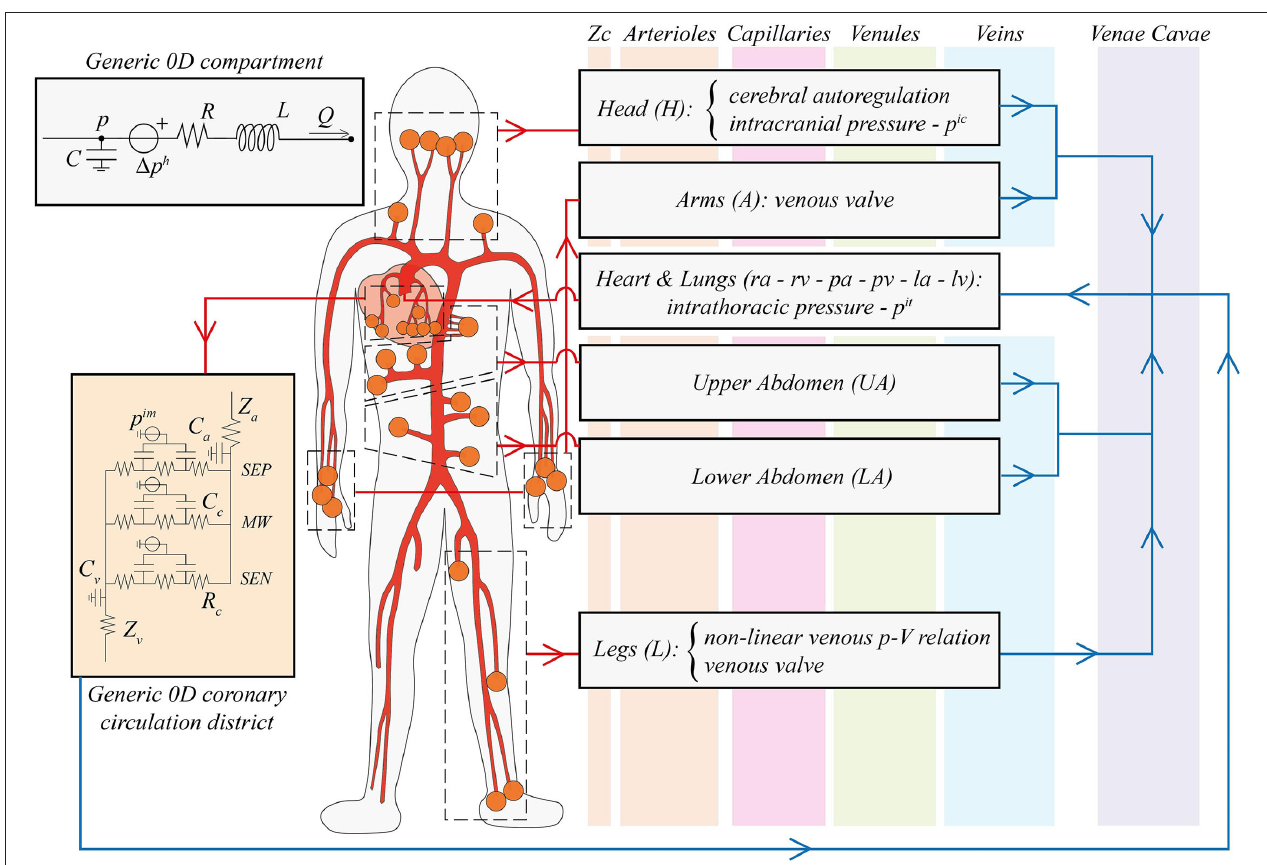
FIGURE 1 | Schematic illustration of the global multiscale cardiovascular model. The thick red network represents the 1D arterial tree, while the vertical colored bands (orange, pink, green, and blue, from left to right) refer to the different compartments of the 0D systemic circulation (from arterioles to venae cavae, respectively). Orange circles indicate a 1D arterial connection with distal 0D arterioles, organized in black dashed boxes by different body regions (head, arms, upper and lower abdomen, legs, plus the coronary circulation). In the right grey boxes, the subdivision of the 0D systemic circulation is reported, specifying improvements of our work associated with gravity alterations: vascular control of cerebral autoregulation, the intracranial pressure p ic , the intrathoracic pressure p it , arms and legs venous valves, and the non-linear pressure-volume relationship for leg veins. The Heart & Lungs 0D compartment includes the right atrium ( ra ) and ventricle ( rv ), pulmonary arteries ( pa ) and veins ( pv ), and the left atrium ( la ) and ventricle ( lv ). Red arrows denote arterial links, whereas blue arrows indicate venous connections. In the top left panel, a generic 0D Windkessel model is depicted: p and Q denote blood pressure and flow rate, R , C , and L are compartmental resistance, compliance, and inertance, 1 p h is the hydrostatic pressure contribution due to gravity. In the orange left panel, a generic 0D coronary microcirculatory district is reported: SEP , MW , and SEN identify myocardial layers, Z a , Z v , C a , C v are arterial and venous input/output impedances and compliances, respectively, R c and C c are intra-layer resistances and compliances, and p im is the intramyocardial